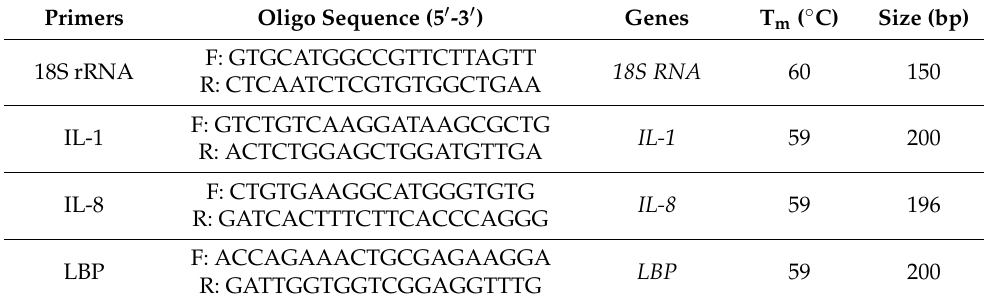
Table 2. Primers used for RT-qPCR